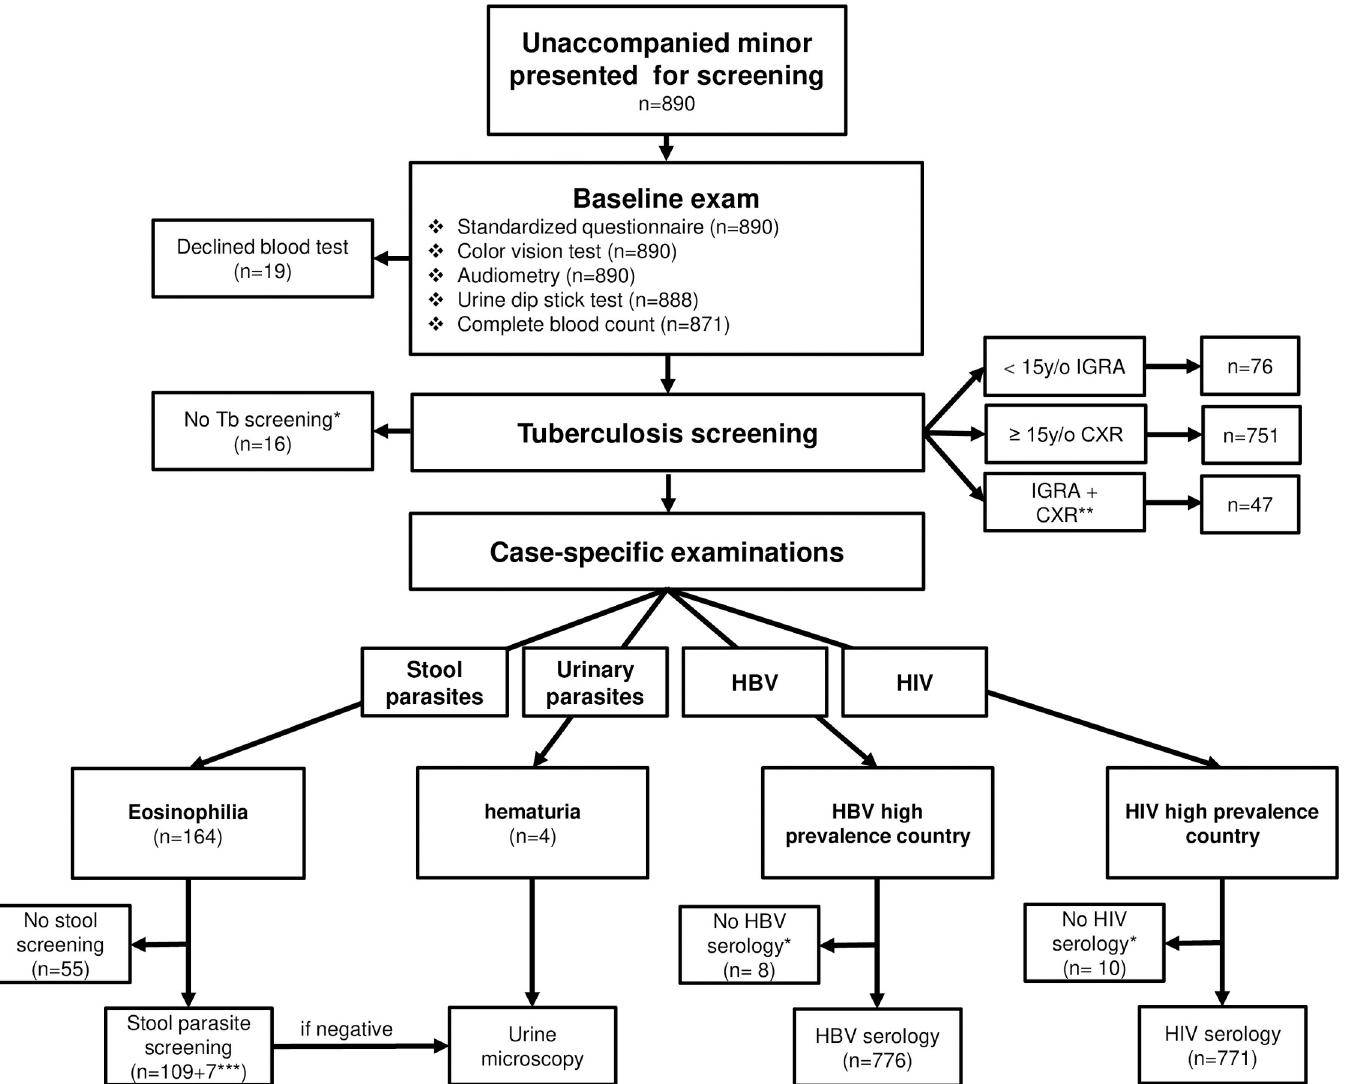
Fig 1. Flowchart of applied screening algorithm in a cohort of unaccompanied refugee minors ( n = 890). � Participants refused screening or previously already screened; �� comprehensive initial diagnostics in symptomatic patients (fever, cough > 2 weeks, loss of weight); ��� patients with gastrointestinal symptoms. Based on Pfeil and colleagues [19]. CXR, chest X-ray; HBV, hepatitis B virus; HIV, human immunodeficiency virus; IGRA, interferon gamma release assay; TB,